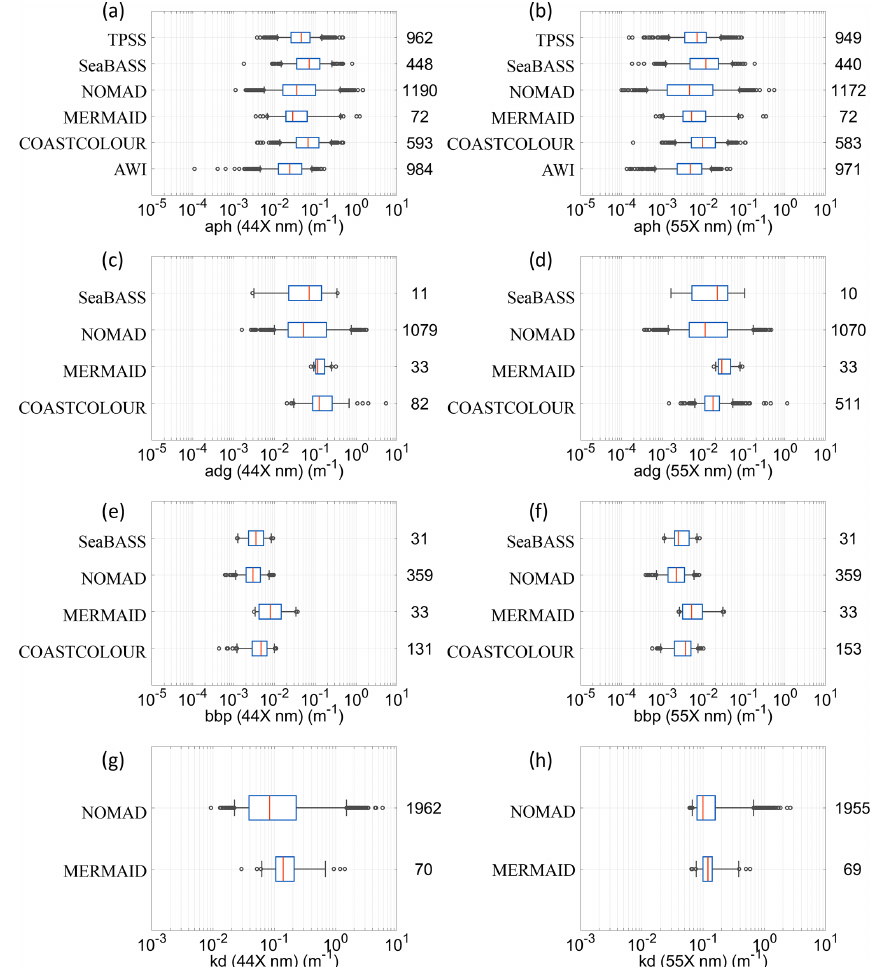
Figure 12. The distribution of: (a) “aph” at 44Xnm; (b) “aph” at 55X; (c) “adg” at 44Xnm; (d) “adg” at 55X; (e) “bbp” at 44Xnm; (f) “bbp” at 55X; (g) “kd” at 44Xnm; (h) “kd” at 55Xnm. Data were first searched at 445 and 555nm, and then with a search window up to 8nm, to include data at 547nm. The graphical convention is identical to Fig.